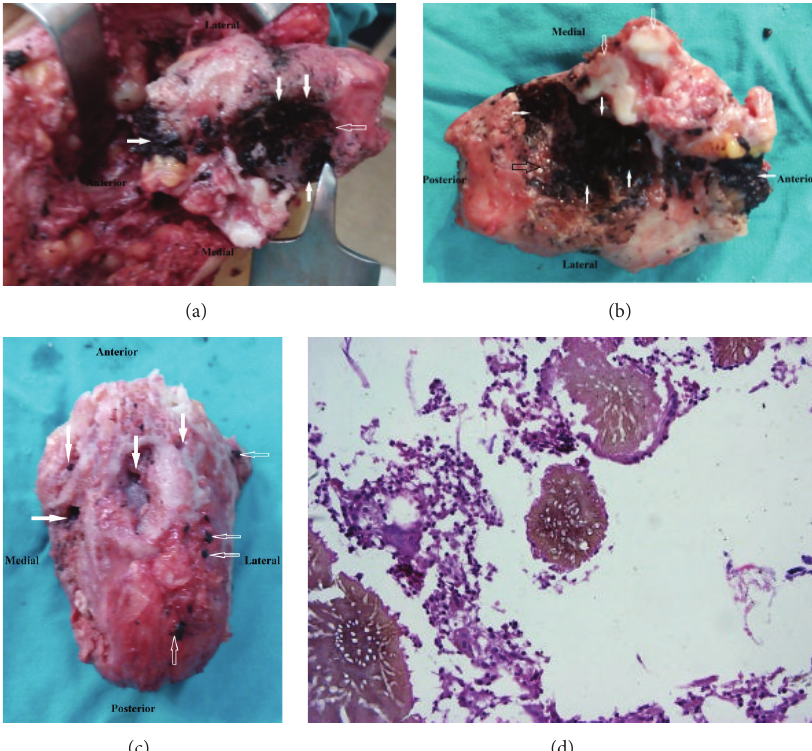
Figure 3: (a) Intraoperative images of superior surface of calcaneus employing the heel splitting approach. Note the extensive conglomerates of black grains scattered over that surface (solid arrows). Note the complete destruction of the articular cartilage of the posterior facet of the subtalar joint (hollow arrows). (b) Operative images of superior surface of calcaneus following total resection, employing the heel splitting approach. Note the extensive conglomerates of black grains scattered over that surface (white solid arrows) and the articular cartilage erosions of the anterior and middle facets of the subtalar joint (hollow white arrows). Complete destruction of the articular cartilage of the posterior facet of the subtalar joint with gross deformation is depicted (hollow black arrow). (c) Operative images of inferior surface of the calcaneus following total resection, employing the heel splitting approach. Note the presence of multiple bony cavities of various sizes (white arrows). Foci of black granular discharge are depicted (hollow arrows). (d) Brown fungal colonies with surrounding inflammatory cells and fibrosis (H and E, ×